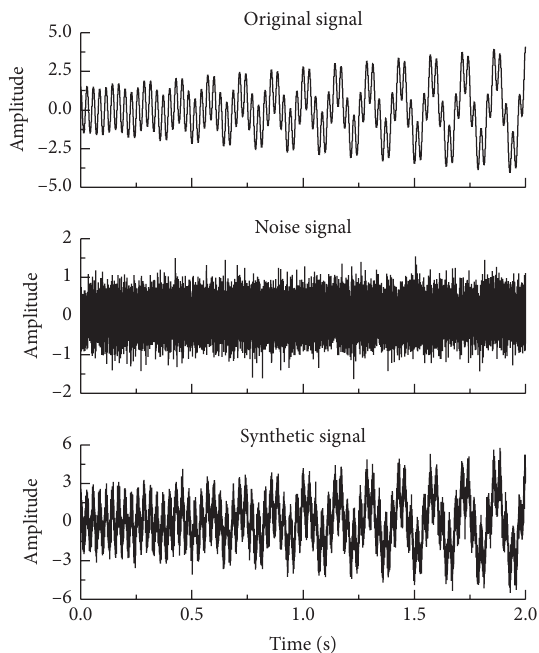
Figure 3: The original signal x ( t ), the noise signal, and the synthetic